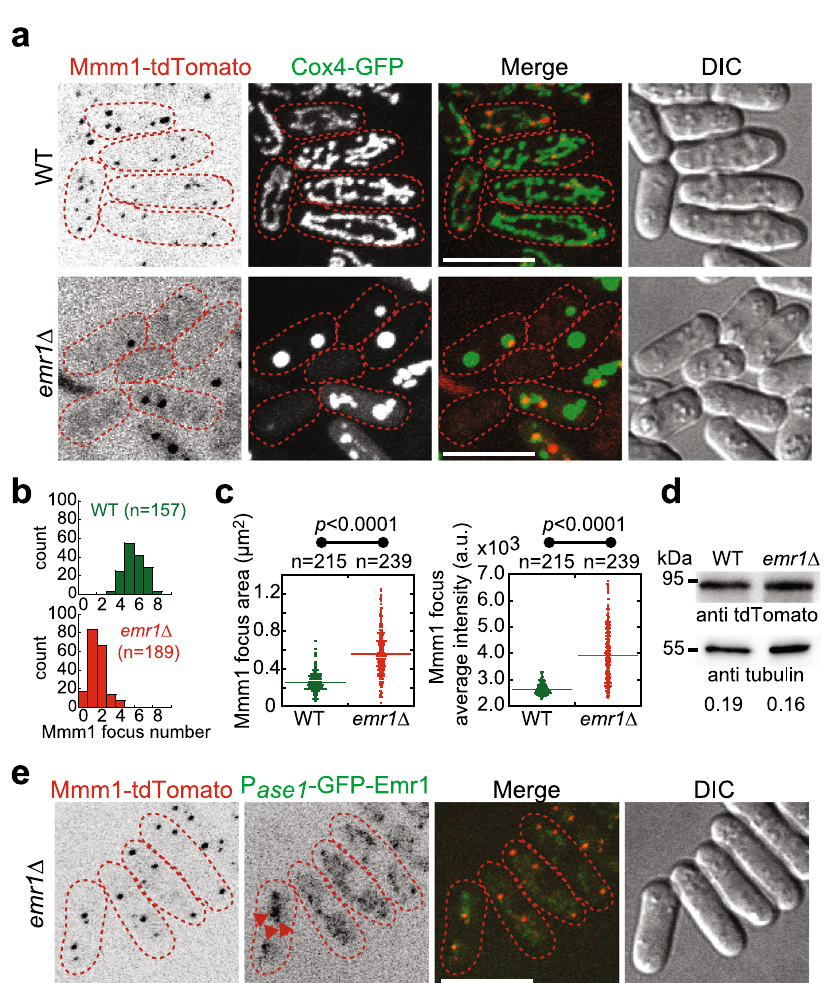
Fig. 5 Emr1 colocalizes with Mmm1 and regulates the number, size, and average intensity of Mmm1 foci. a Maximum projection images of WT and emr1 Δ cells expressing Mmm1-tdTomato (a component of the ERMES complex) and Cox4-GFP. Dashed lines mark the edge of cells. Scale bar, 10 μ m. b Histogram of the quanti fi cation of Mmm1-tdTomato focus number for WT and emr1 Δ cells indicated in a . n indicates the number of cells observed for the quanti fi cation. c Quanti fi cation of Mmm1-tdTomato area and average intensity, respectively, in WT and emr1 Δ cells. Two-sided Student ’ s t-test was used to calculate p -values (area, p < 0.0001; intensity, p < 0.0001). n indicates the number of foci observed for quanti fi cation. d Western blotting analysis of the expression levels of Mmm1-tdTomato in WT and emr1 Δ cells. Antibodies against tdTomato and tubulin were used. Number below is the intensity ratio of tdTomato over tubulin. e Maximum projection images of emr1 Δ cells expressing Mmm1-tdTomato and GFP-Emr1 (from the ase1 promoter). GFP-Emr1 foci co-localized with Mmm1-tdTomato (indicated by red arrowheads). Dashed lines mark the edge of cells. Note that the number of Mmm1-tdTomato foci signi fi cantly increased in the cells (vs. the one in emr1 Δ cells). Scale bar, 10 μ m.